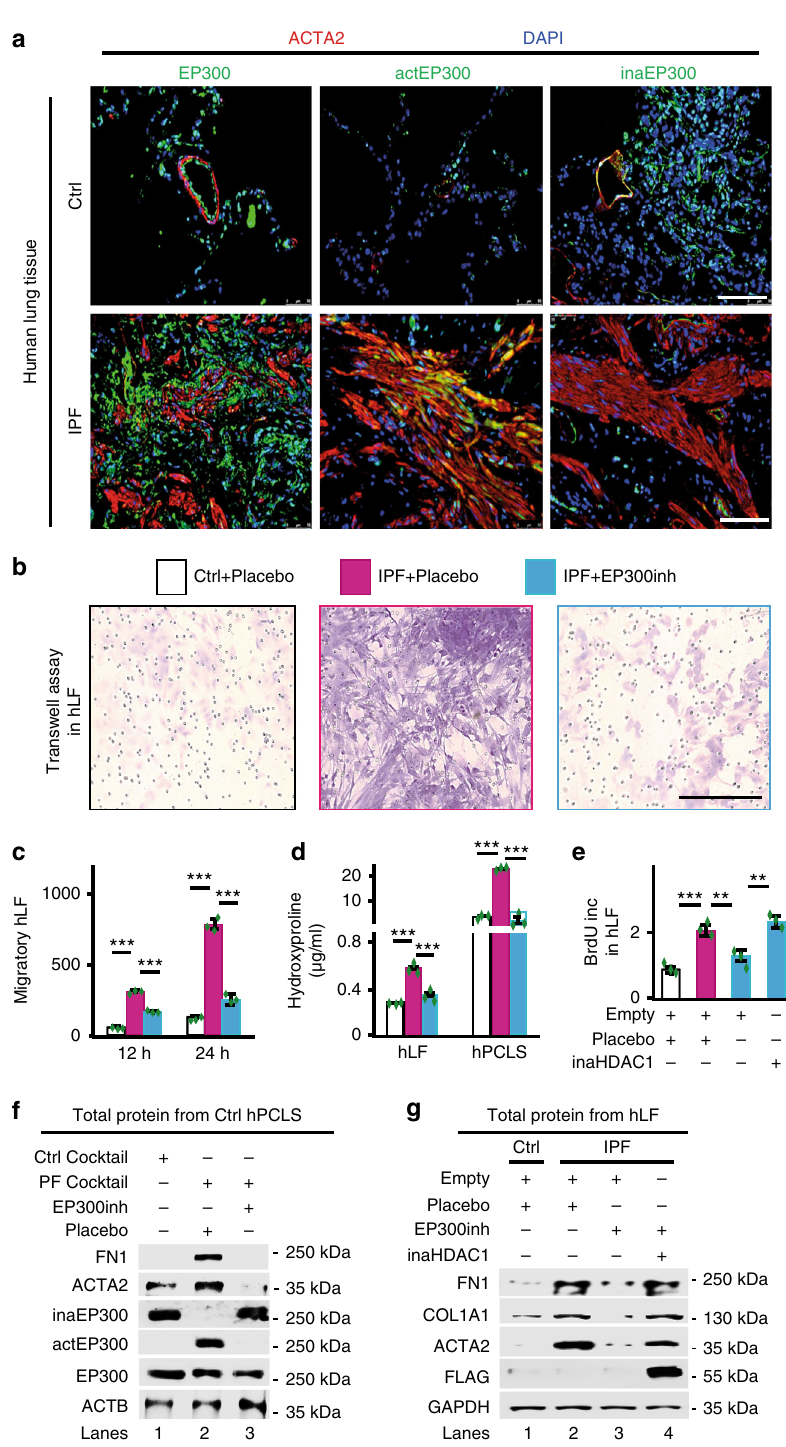
Fig. 8 EP300inh counteracts fi brosis hallmarks in IPF models. a Confocal microscopy after ACTA2, EP300, actEP300, and inaEP300 immunostaining